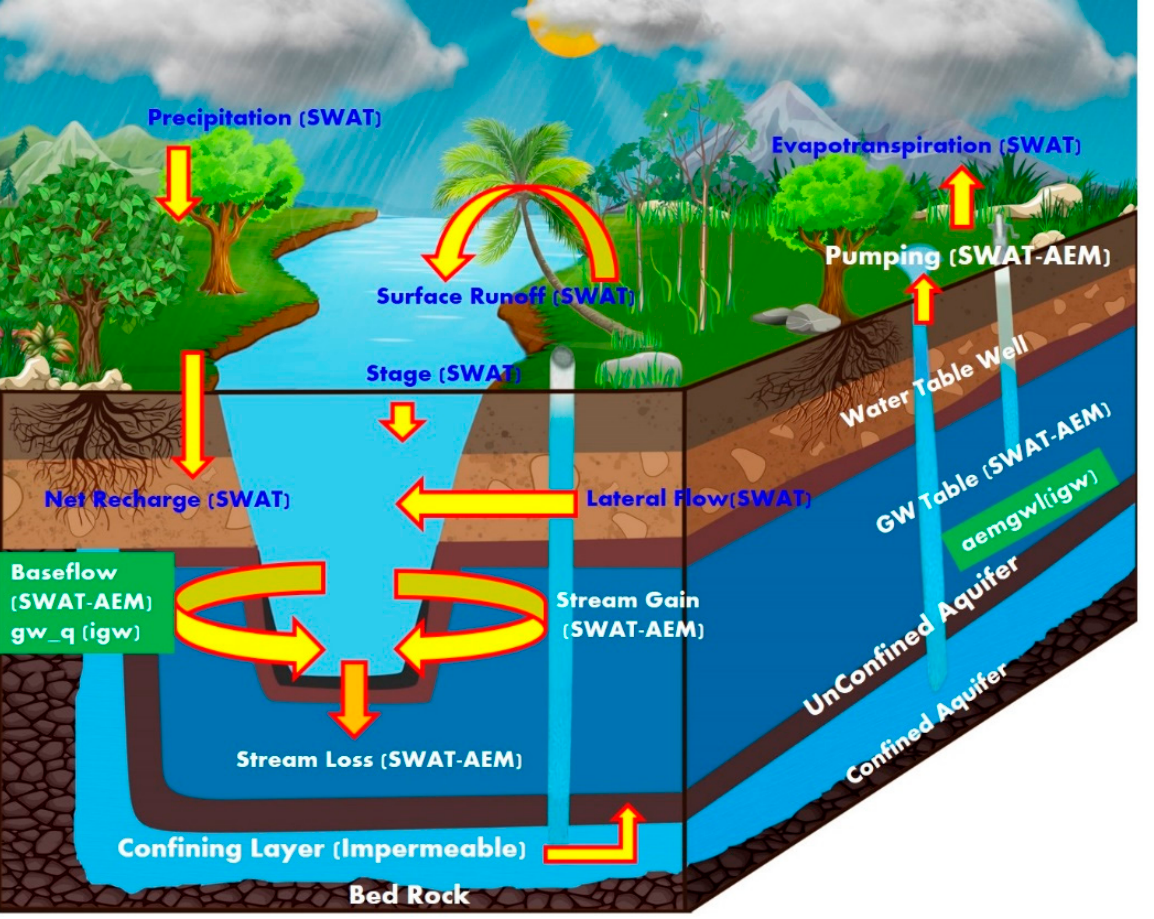
Figure 3. Schematic diagram representing the interaction of integrated Surface and ground water model.